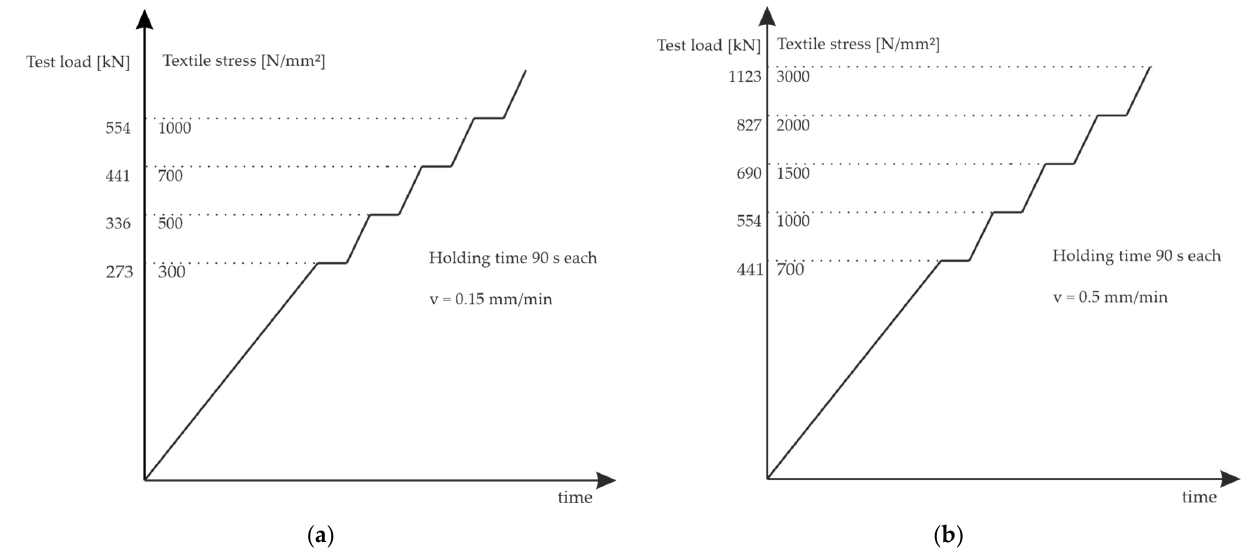
Figure 19. Planned load regime: ( a ) specimen 1; ( b ) specimen 2. (Graphic: HTWK Leipzig).